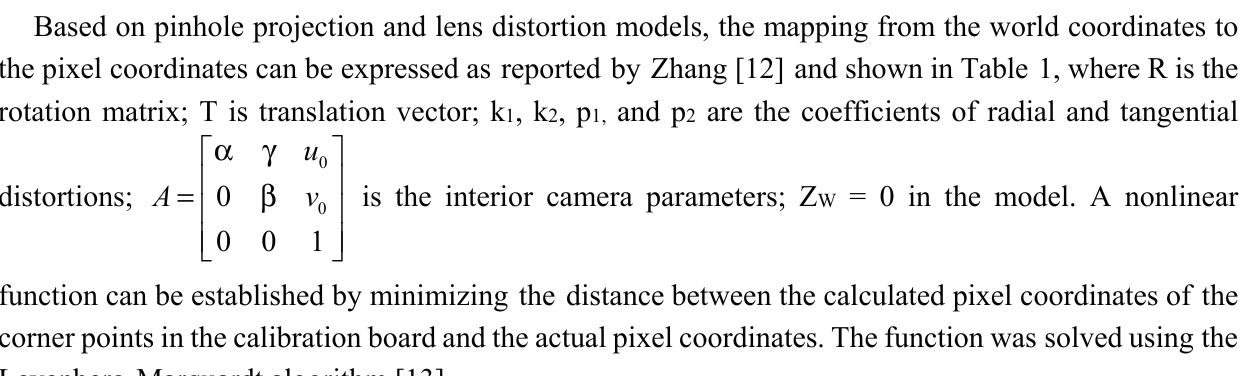
Figure 5. Calibration model of the line structured light.